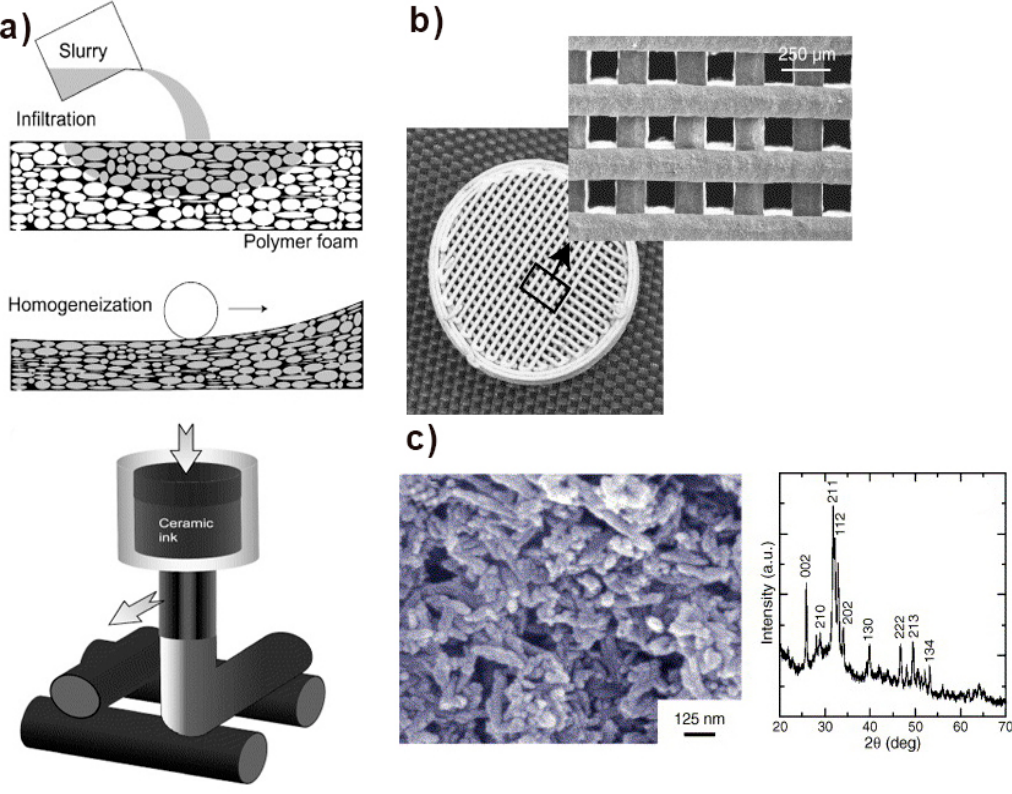
Figure 10. ( a ) Graphical representation of methods used in the manufacturing of porous ceramic scaffolds ( b ) Microstructure of HA scaffolds fabricated by robocasting ( c ) SEM micrograph and XRD of HA powders used in this process [81].